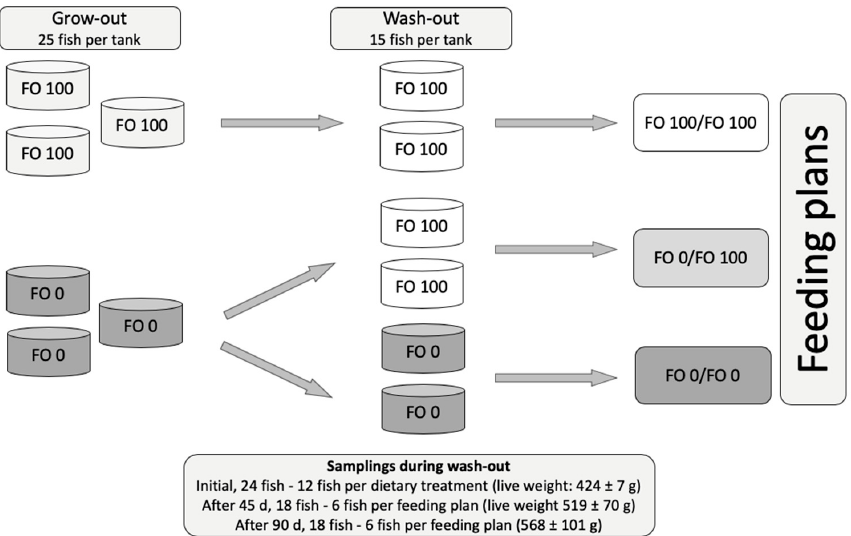
Figure 1. Scheme of feeding plans and samplings. During grow-out (109 d), fish were fed FO 100 diets (formulated with fish oil as lipid source) or FO 0 diets (formulated with vegetable oil as lipid source) (three tanks per experimental diet). At the end of grow-out, the same fish were moved into 6 tanks and fed FO 100 diets or FO 0 diets for the wash-out period (90 d) resulting into three feeding plans: FO 0 / FO 0, FO 0 / FO 100, and FO 100 / FO 100 (two tanks per feeding plan). Fish were sampled at the beginning, and after 45 d and 90 d of wash-out.